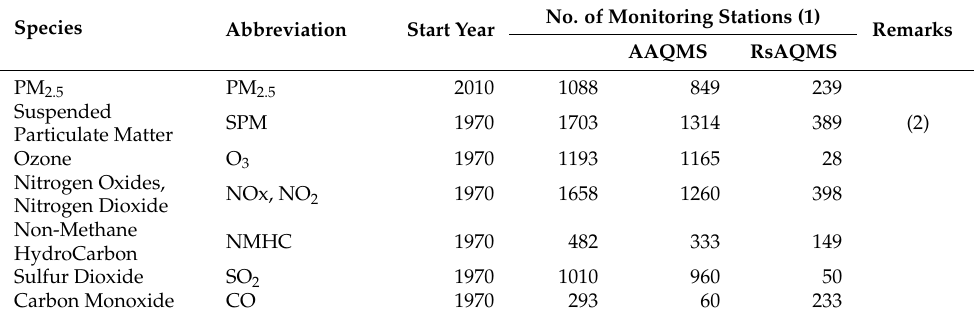
Table 1. Air pollutants, start year of the measurements and the number of stations as of 2018.